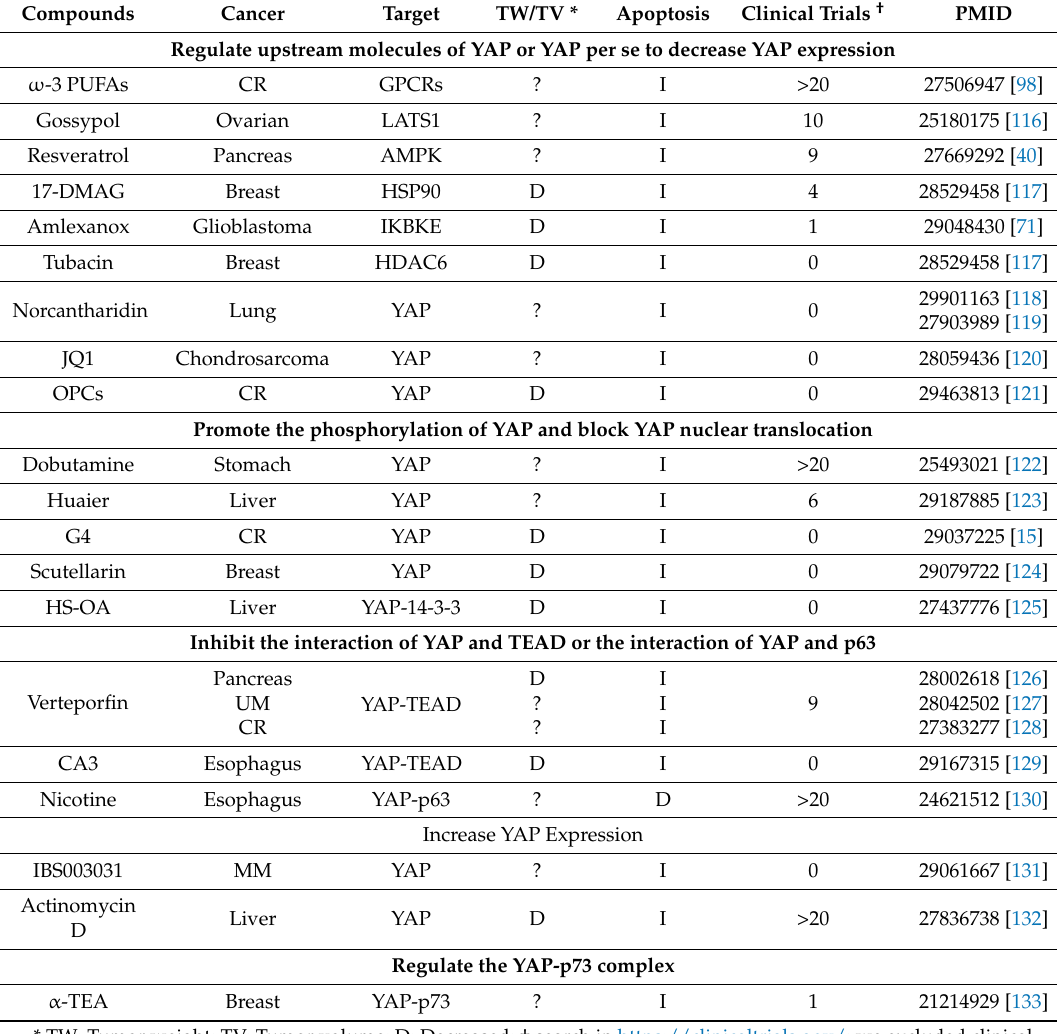
Table 3. Compounds regulating Hippo-YAP signaling, tumor progression, and apoptosis.